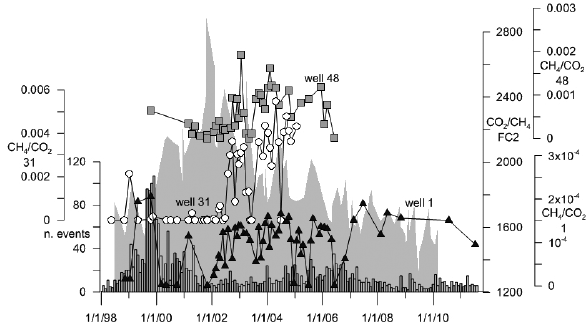
/CO molar ratios in the dissolved Figure 9. Time trends of CH 4 2 gas phase at selected sites (namely wells 1, 31, and 48). The time /CH molar ratios, measured at the crater fumarole by trend of CO 2 4 Caliro et al. [2011], is plotted as a shaded area. The histogram shows the monthly number of seismic